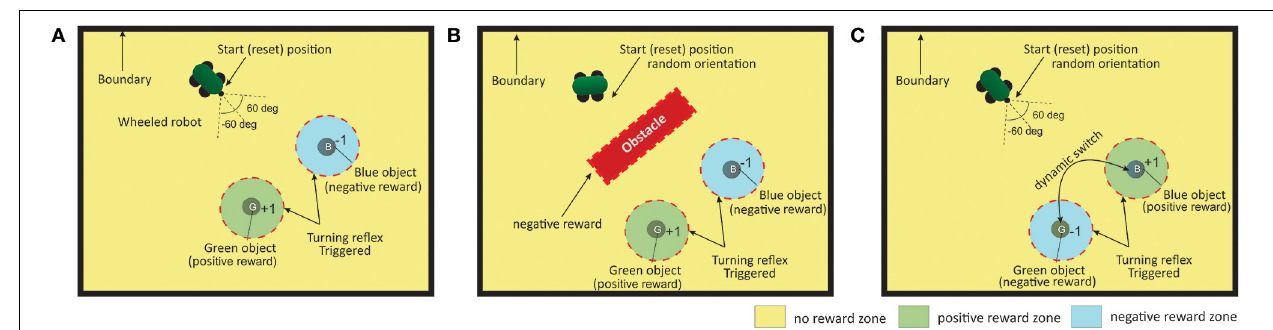
FIGURE 6 | Three different scenarios for the goal-directed foraging task. (A) Environmental setup without an obstacle case. Green and Blue objects represent the two food sources with positive and negative rewards, respectively. The red dotted circle indicates the region where the turning reflex response (from the ICO learner) kicks in. The robot is started from and reset to the same position, with random orientation at the beginning of each trial episode. (B) Environmental setup with an obstacle. In addition to the previous setup, a large obstacle is place in